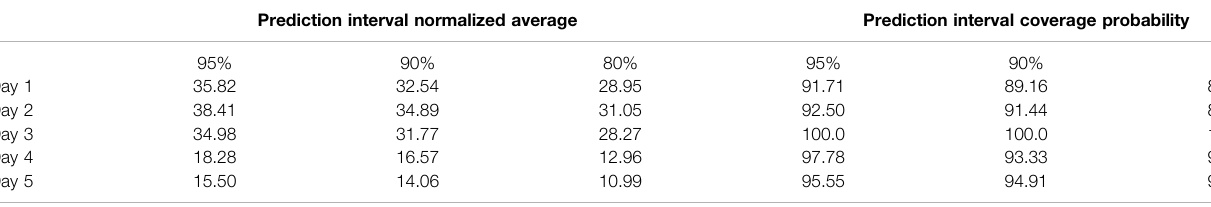
TABLE 4 | Indicator results based on the improved generalized error mixture distribution.